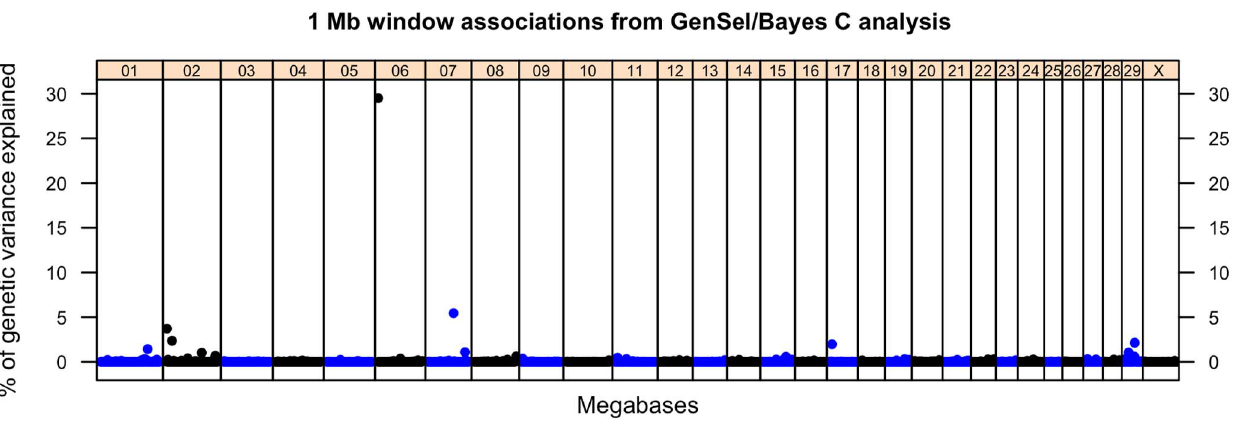
Figure 2. Manhattan plot for 1 Mb window (Bayes C/GenSel) analysis of combined discovery and validation data sets. Each dot represents the percent of genetic variance explained by multiple SNPs within a 1 Mb window. Percent of variance is indicated on the y-axis and map location of the SNP is indicated on the